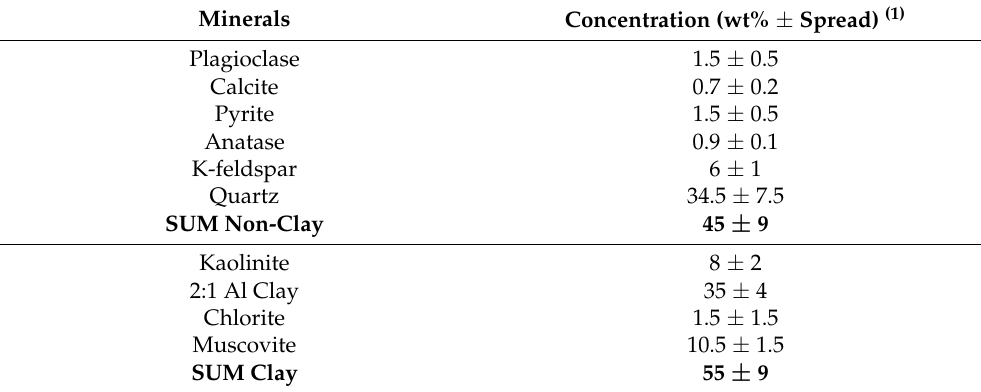
Table 1. Composition of the BC core CG72–73W_core 13_Section 13.1 measured by XRD on two